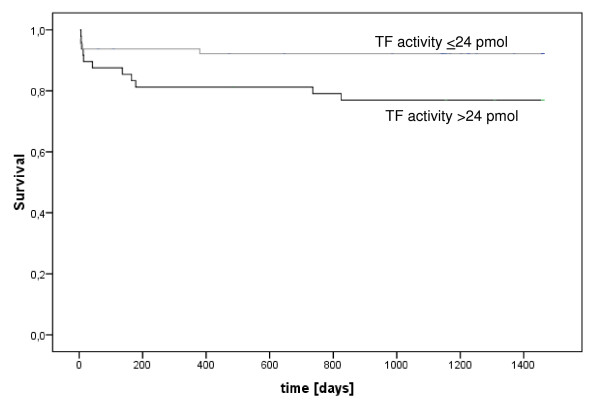
Kaplan-Meier cardiovascular mortality curves according to low and high TF activity in AMI. Patients with AMI were divided in a group with high (> 24 pmol/L) and a group with low plasma TF activities on admission (≤ 24 pmol/L). (p = 0,03).